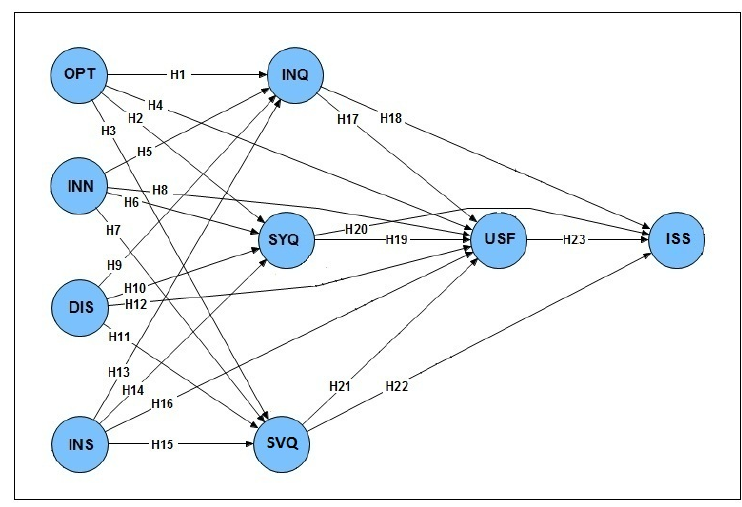
Figure 1. Research model adopted and adapted from Subiyakto’s [39,40] ISRS model.